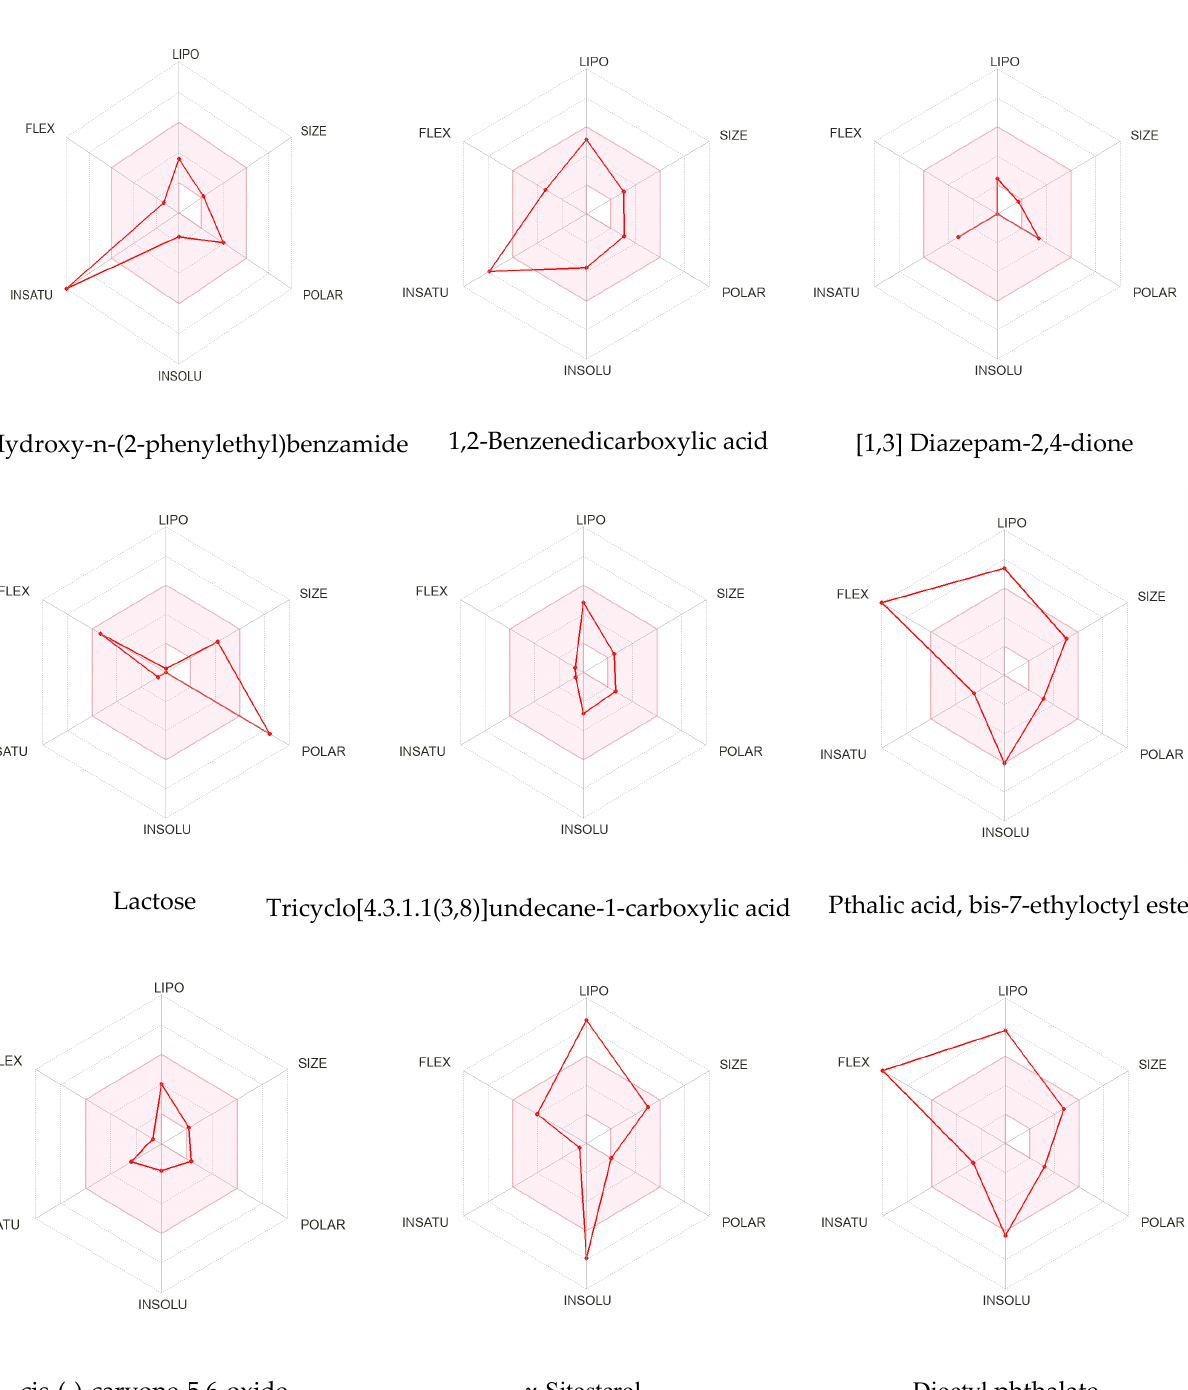
Figure 4. Bioavailability radars, the pink area on the radar shows oral bioavailability. FLEX: Flexibility, LIP: lipophilicity, POLAR: polarity, and INSATU: saturation.